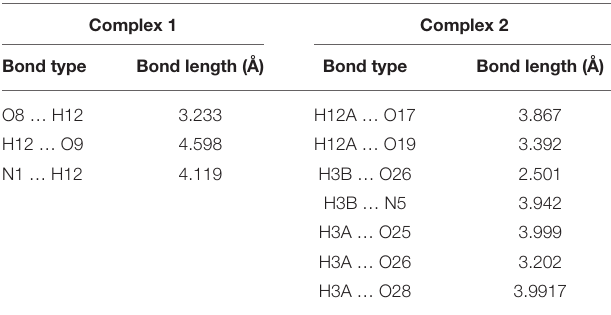
TABLE 4 | Selected H-bond length (Å) for complexes 1 and